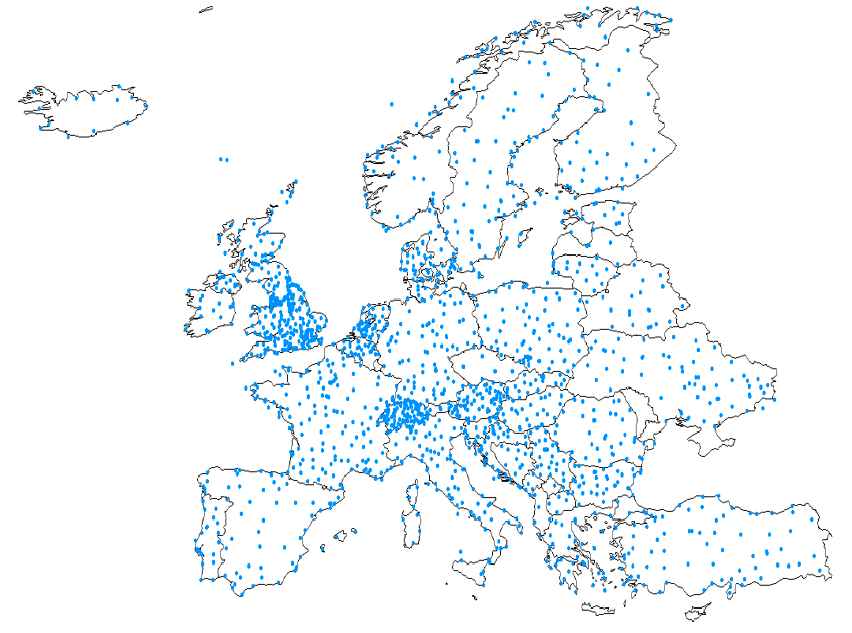
Figure 1. Spatial distribution of the sample points.